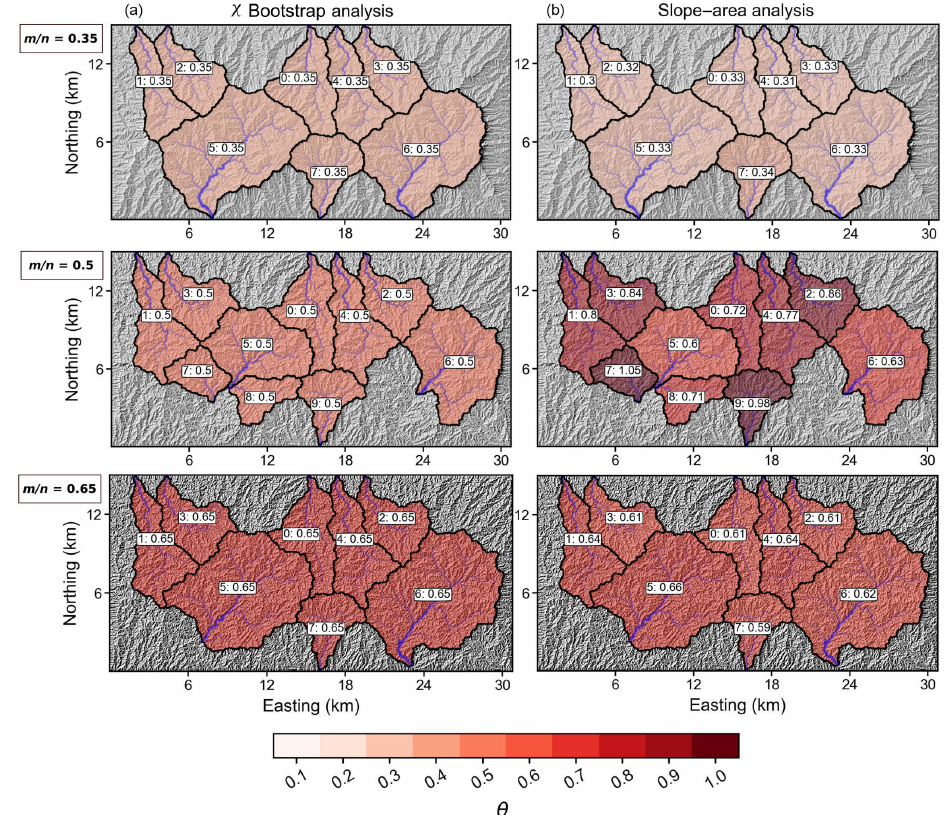
Figure 5. Shaded relief plots of the model runs with temporally varying uplift, with drainage basins plotted by the best-fit θ predicted from the χ bootstrap analysis (column a ), and slope–area analysis (column b ). Each row represents a model run with a different m/n ratio. The basins are coloured by the predicted θ , where darker colours indicate a higher concavity index. The extracted channel network for each basin is shown in